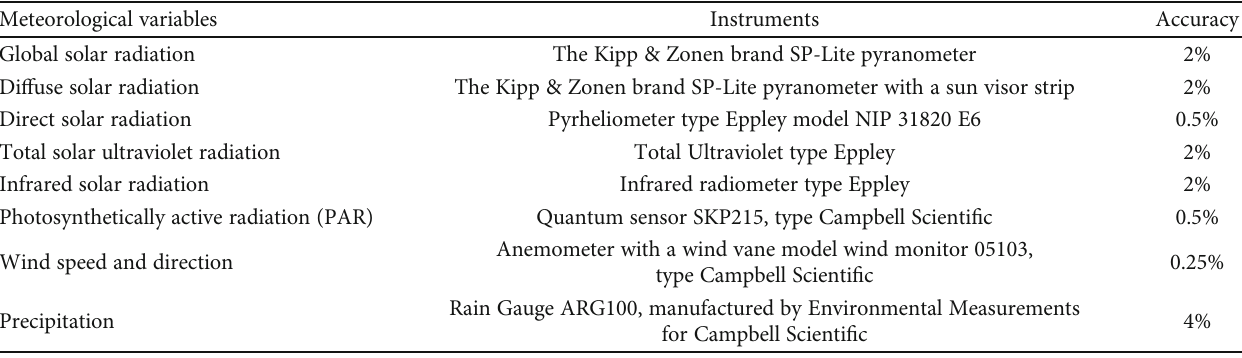
Table 2: Characteristics of measuring